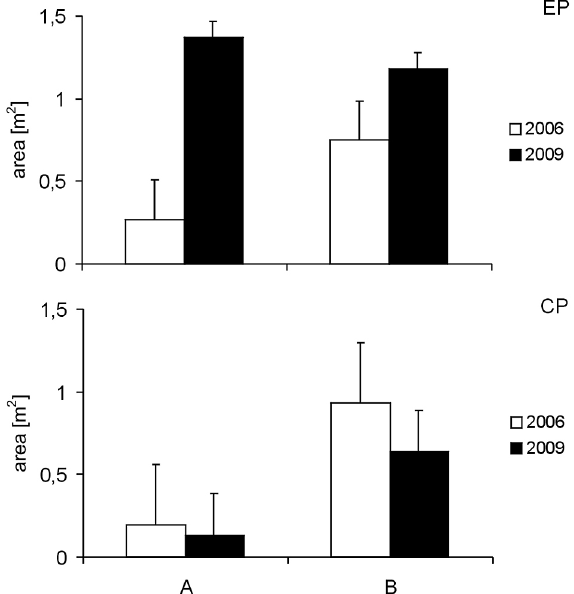
Fig. 7. Influence of mowing on Calamagrostis stricta dispersal in sedge communities overgrowing marginal zone (A) and riverbed-adjacent zone (B) of the Chwiszczej river valley. EP – experimental plots (mown), CP – control plots (unmown).